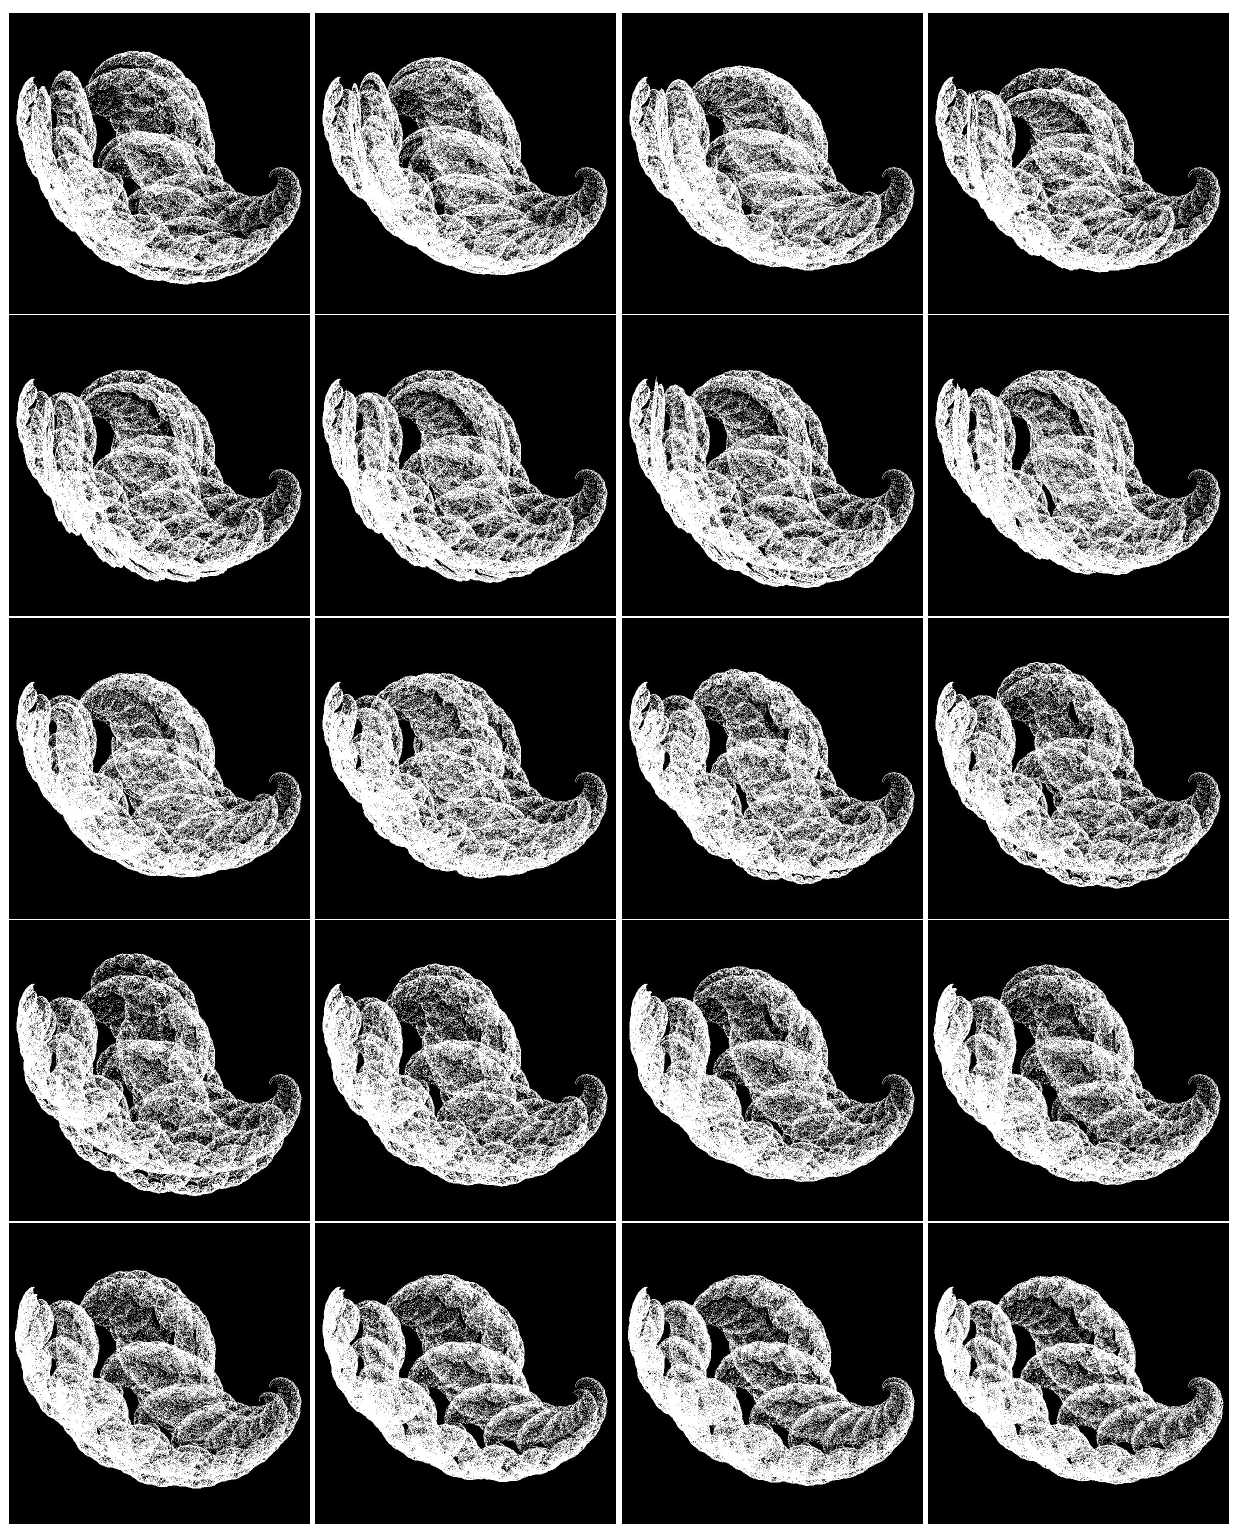
Figure 12. ( left – right , top – bottom ): Evolution of the union between the original and the recon- structed images for 800–1180 iterations (step size, 20